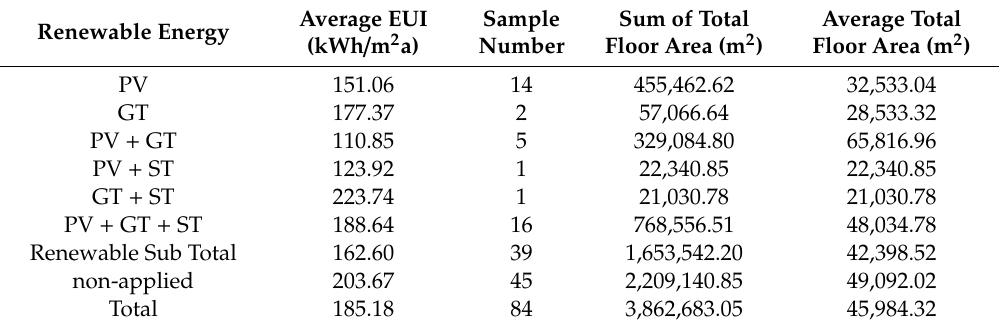
Table 8. Average EUI of G-SEED Certified Buildings according to Renewable Energy Installation. Renewable Energy